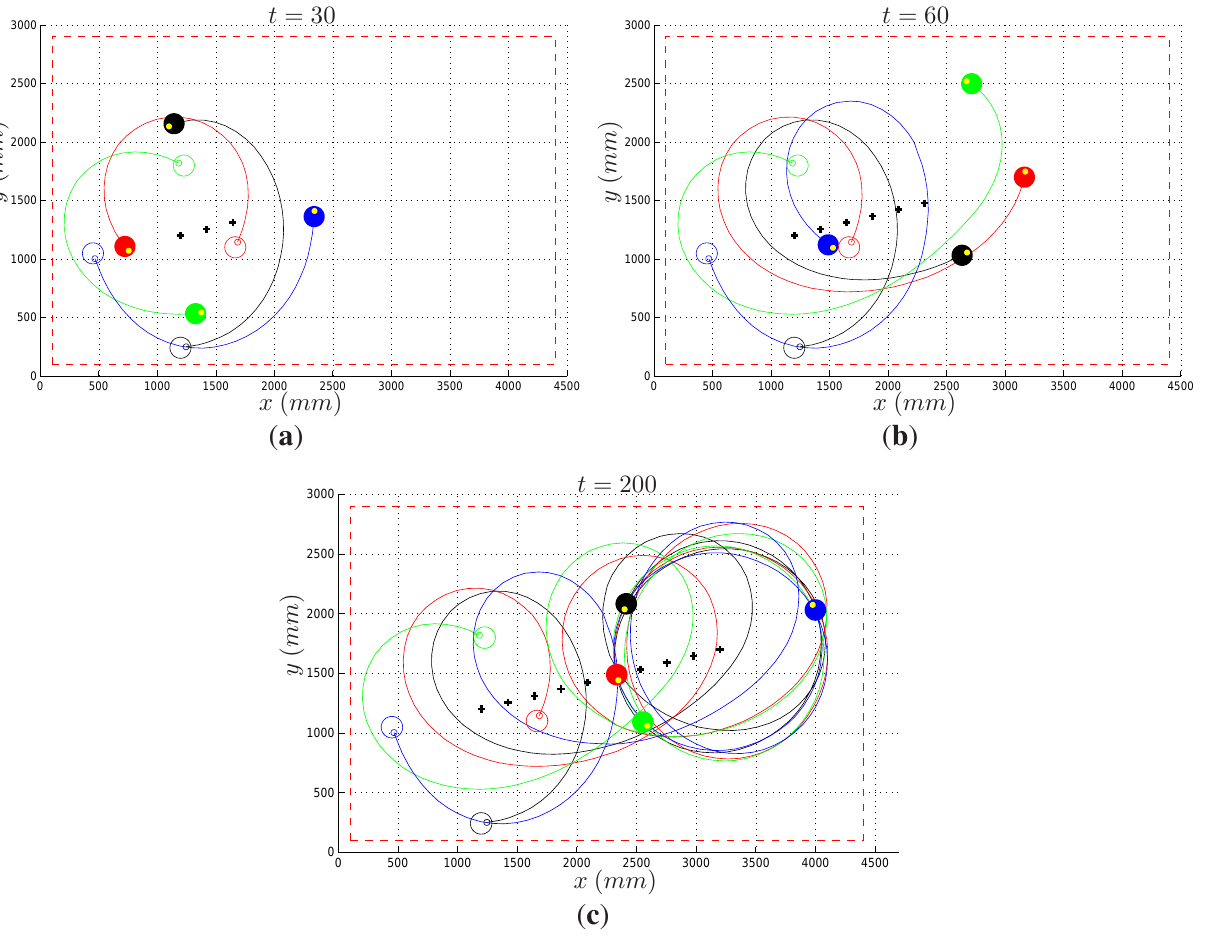
Collective circular motion: three snapshots taken at time t = 30 s ( a ); t = 60 s ( b ); and t = 200 s ( c ). Initial (empty circle) and current (filled circle) robot position; actual robot path (solid line); reference beacon